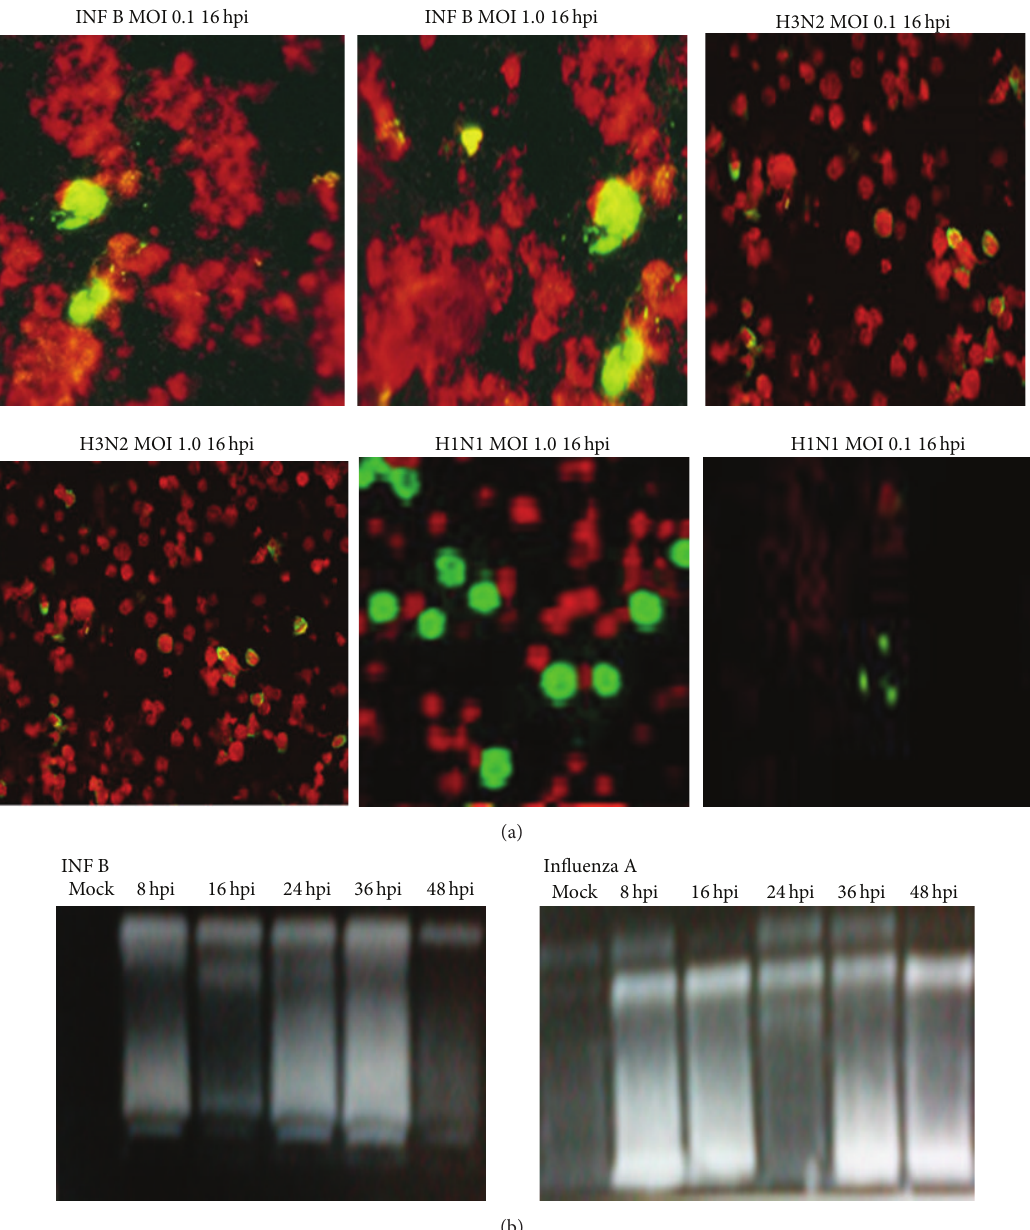
Figure 3: Influenza A and b viruses induce apoptosis in A549 and MDCK II cells at MOI 1.0. (a) Nuclear staining of the infected cells with FITC staining. (b) Chromosomal DNA fragmentation. DNAs were prepared from A549 cells infected with virus at 8 h intervals and separated by 2% agarose gel electrophoresis, followed by staining with ethidium